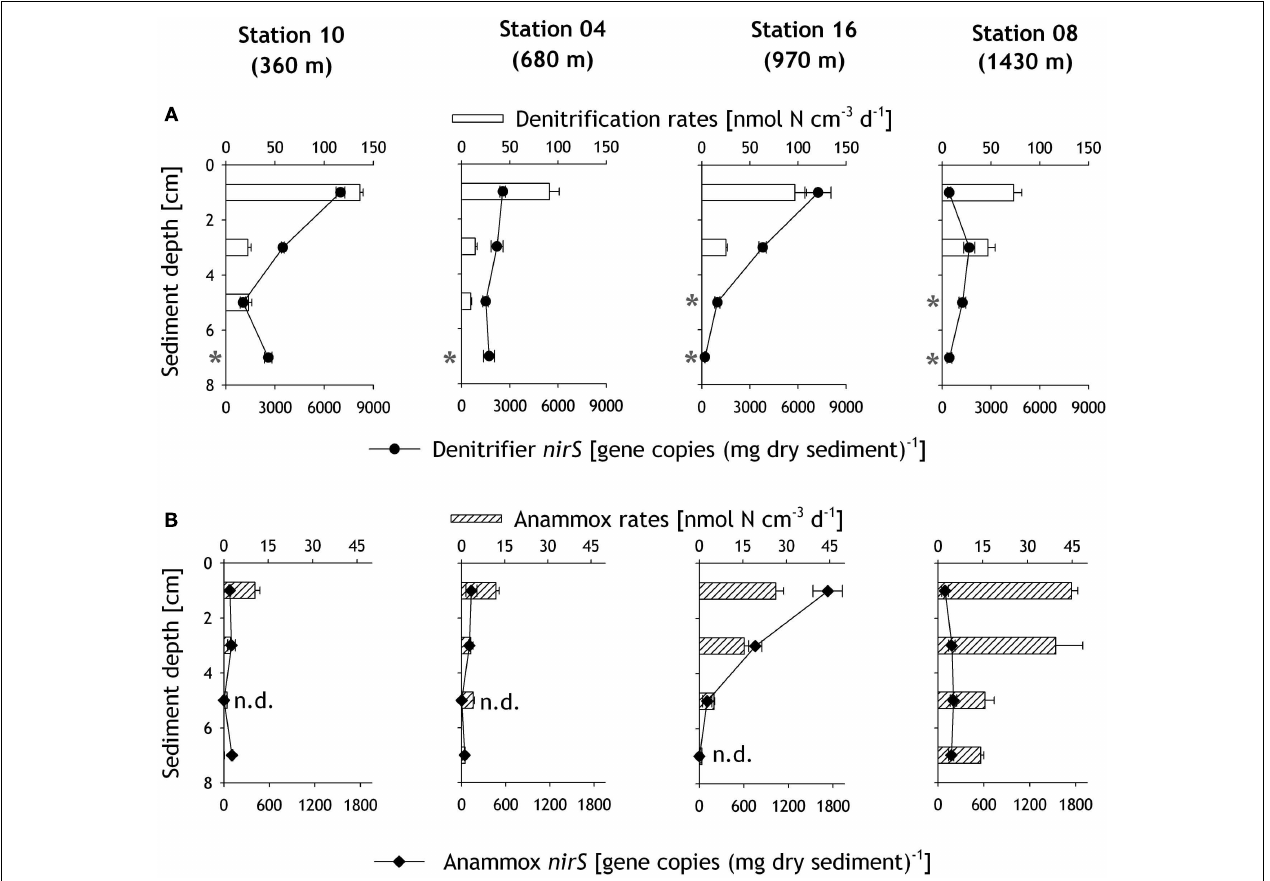
FIGURE 4 | Denitrification (A) and anammox (B) rates determined from slurry incubation experiments, along with the corresponding gene copy numbers of denitrifier nirS (A) and anammox nirS (B) quantified by